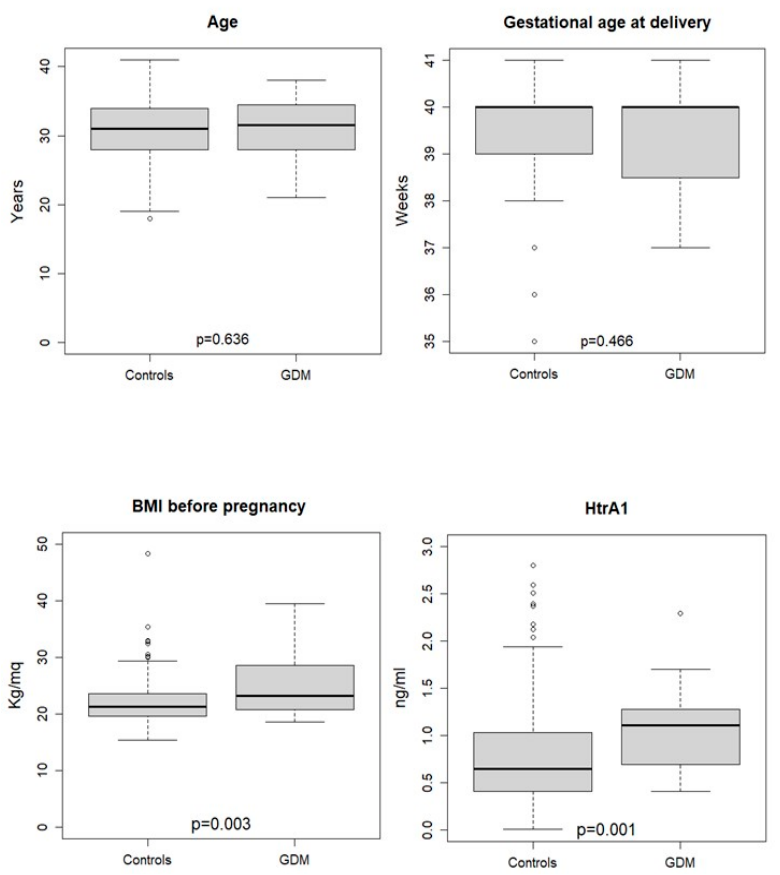
Figure 1. Women’s demographic and clinical characteristics according to health status at the first trimester of gestation. p -values refer to Wilcoxon rank sum test. trimester of gestation. p -values refer to Wilcoxon rank sum test. Table 2. Women’s lifestyle according to health status at the first trimester of gestation.